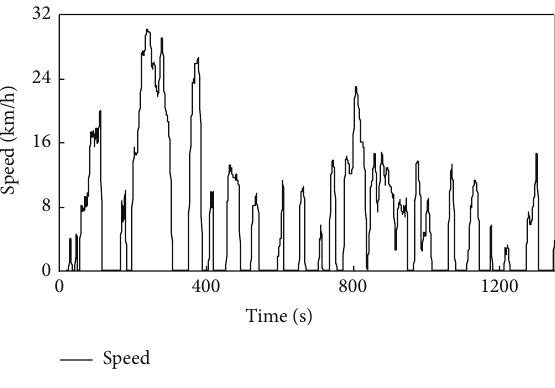
Figure 5: CYC UDDS golf drive cycle.